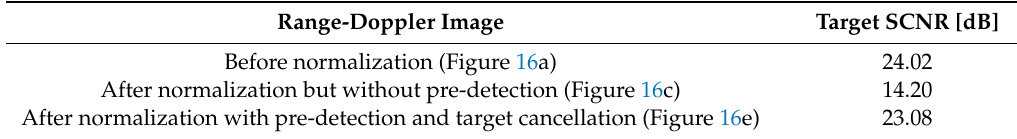
Table 1. Measured target SCNR before and after clutter normalization.